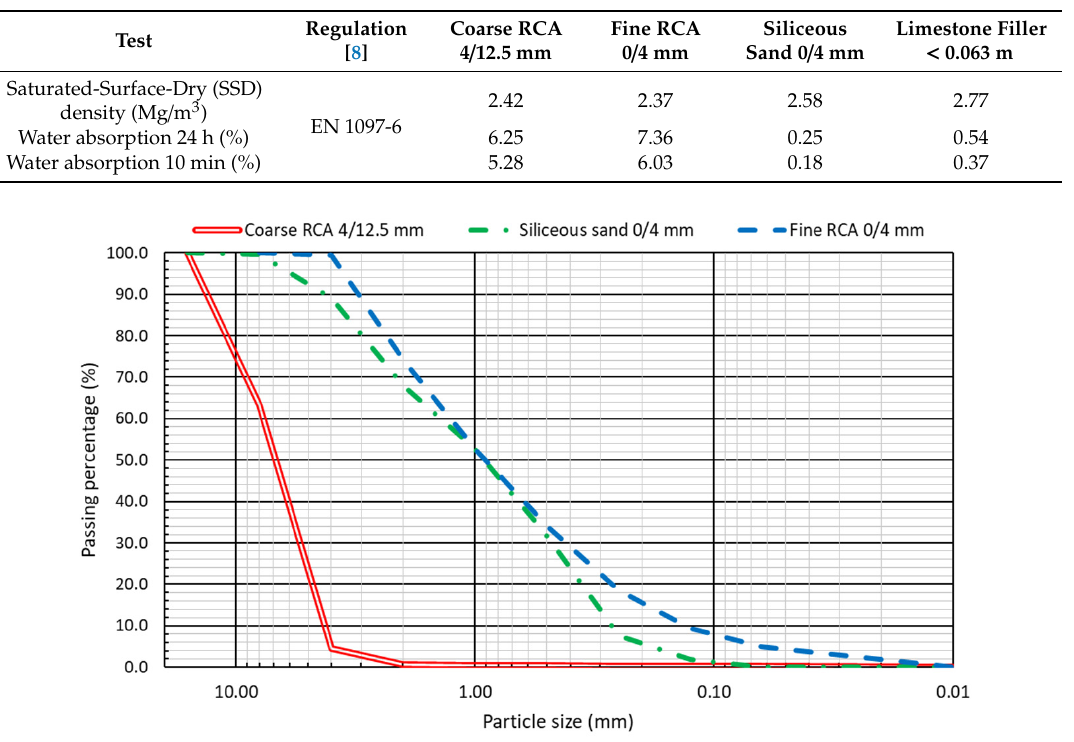
Table 1. Physical properties of the aggregates.